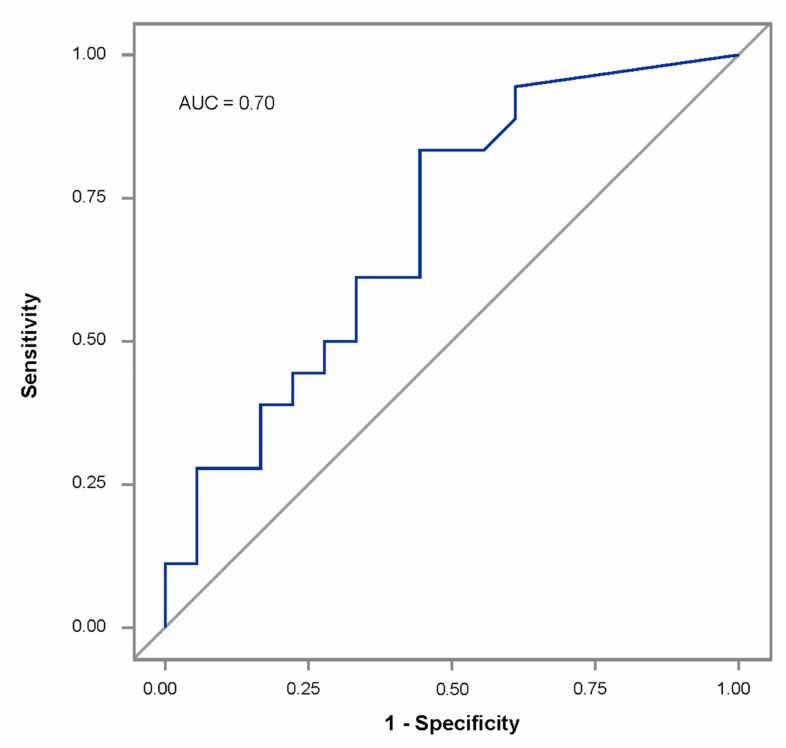
Figure 2. Receiver operating characteristic / area under the curve (ROC / AUC) analysis of bronchoalveolar lavage fluid (1,3)- β - d -glucan (BDG) concentrations to distinguish Pneumocystis pneumonia cases from matched controls, AUC 0.70 (95% C.I.